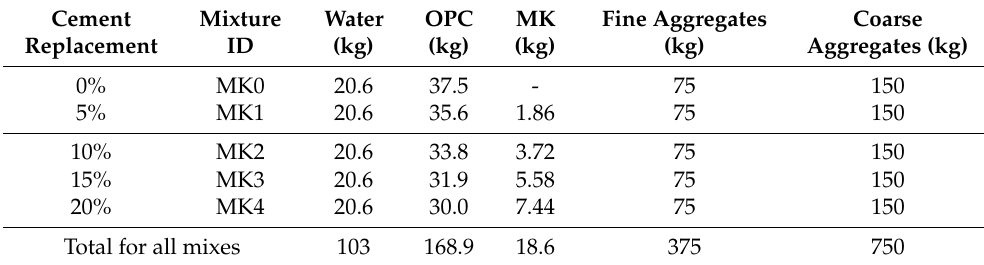
Table 8. Weights of the material used in casting specimens.